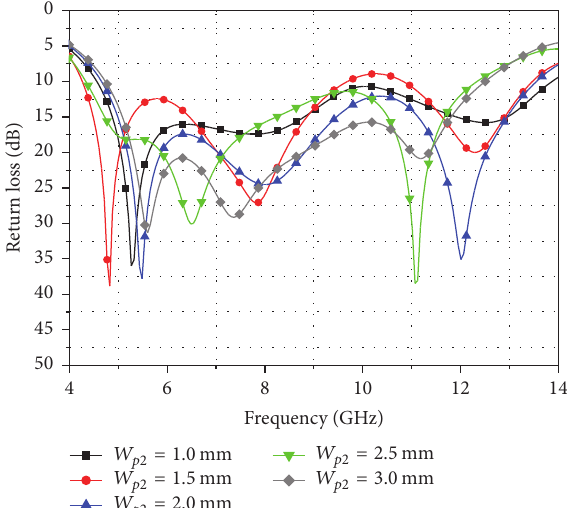
Figure 12: Simulated return loss against frequency for the proposed defectedsubstratewidebandantennawithvarious 𝐿 𝑝𝑔 ;otherparam- eters are the same as listed in Table 1.